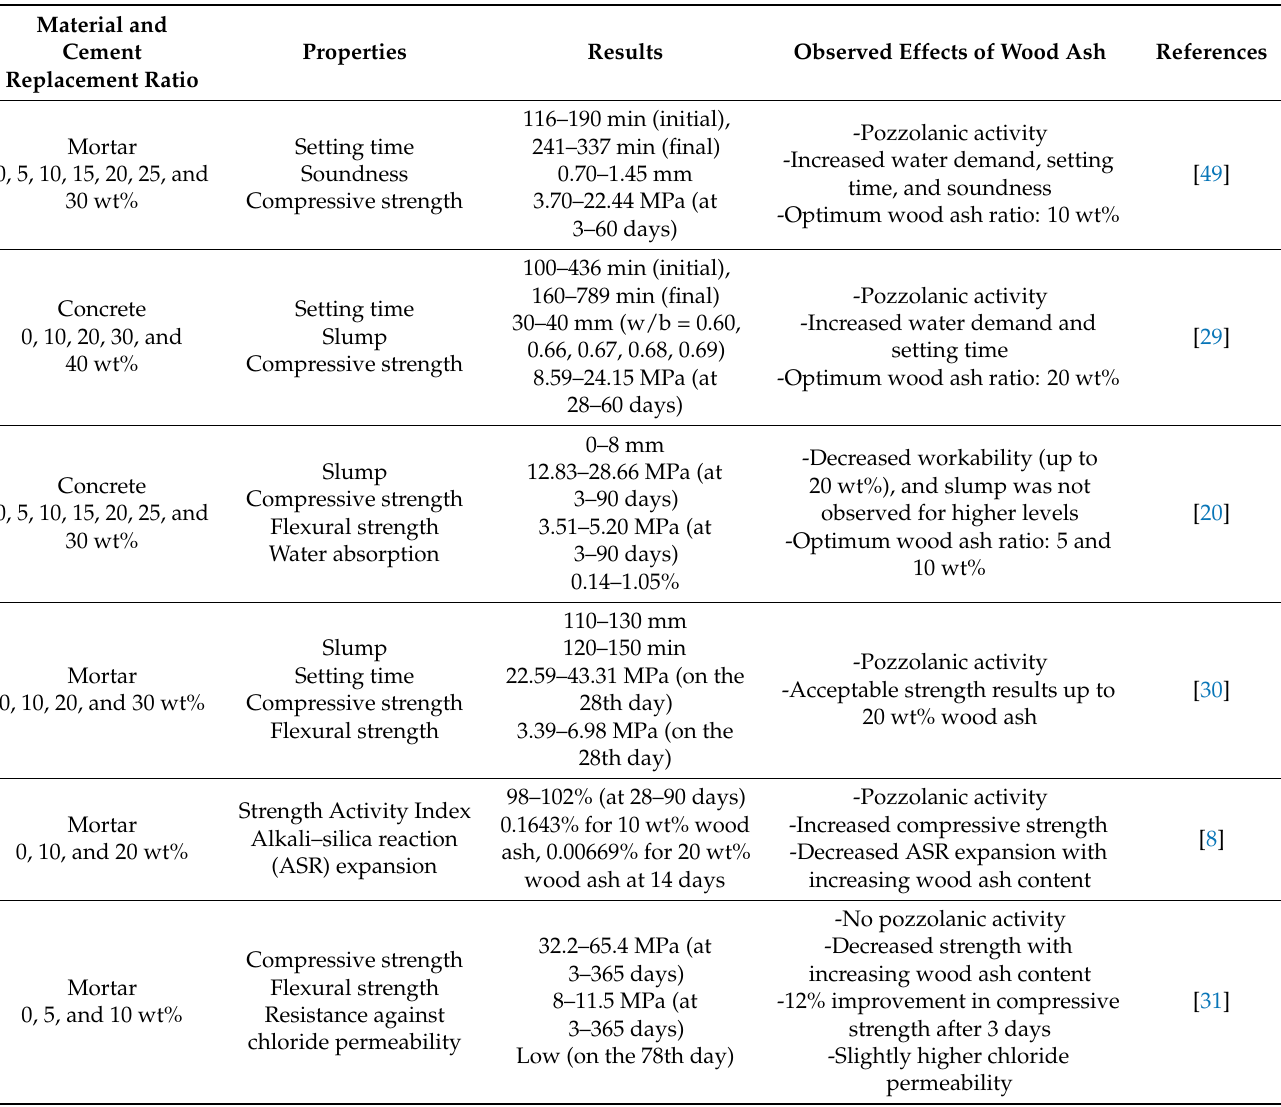
Table 2. Table 2. Effects of wood ash incorporation on mortars and